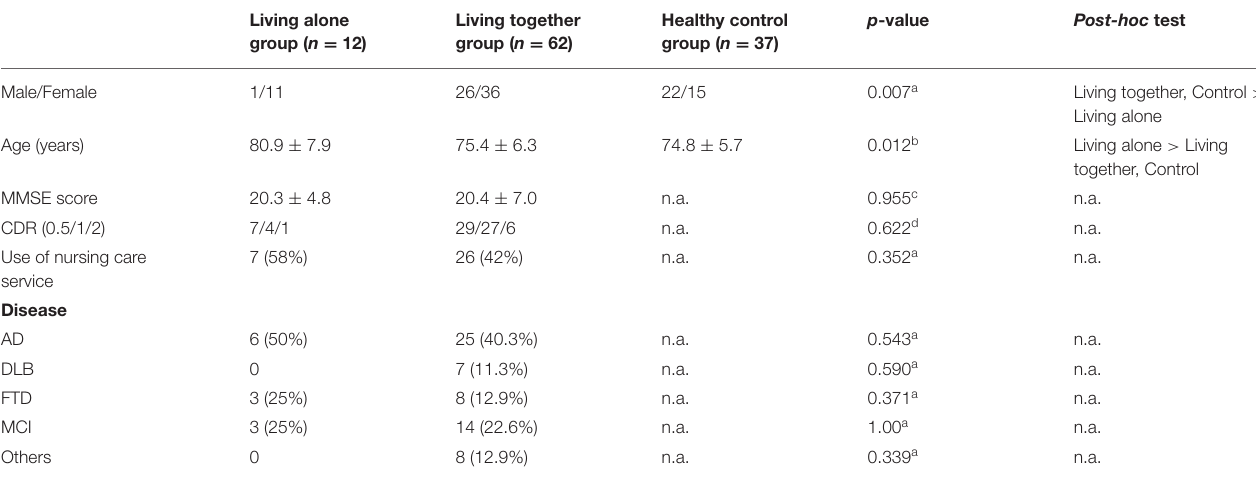
TABLE 2 | Subjects’ demographics.